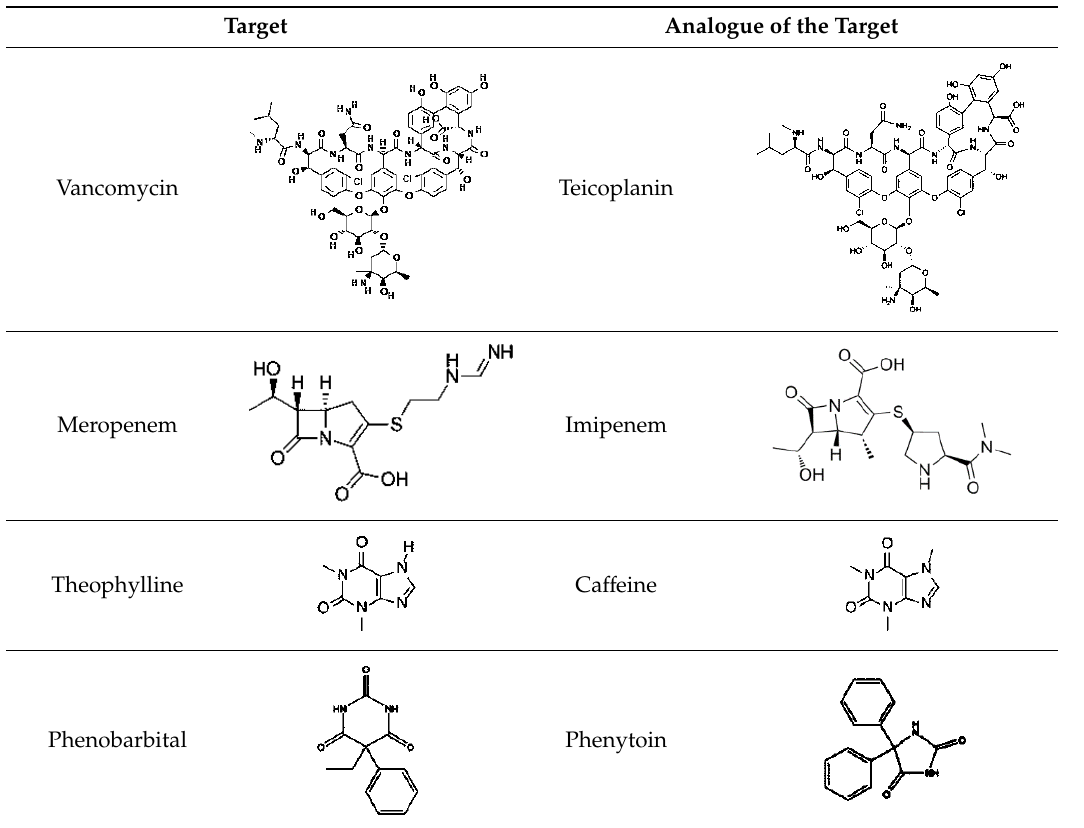
Table 1. Structural similarity between target drugs under study and their analogues.